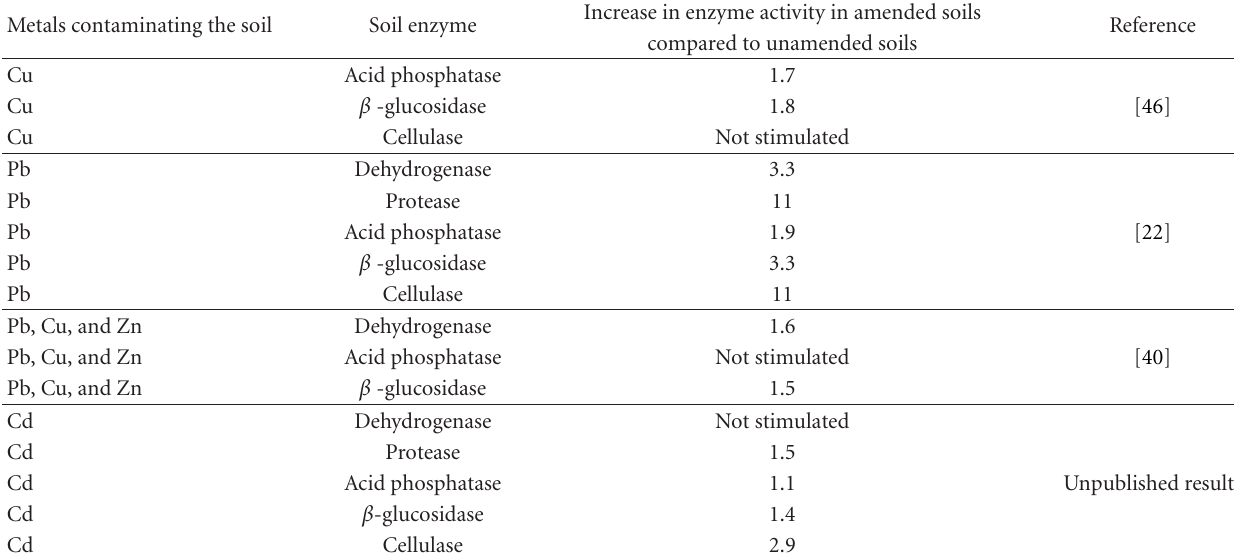
Table 3: Enzyme activity of polymer-amended metal-contaminated